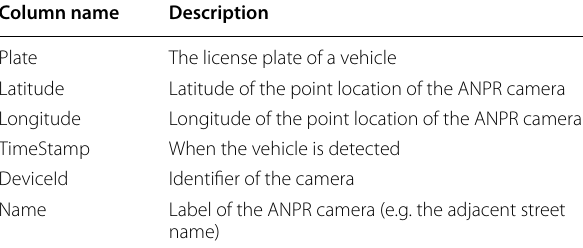
Table 1 CSV structure of ANPR